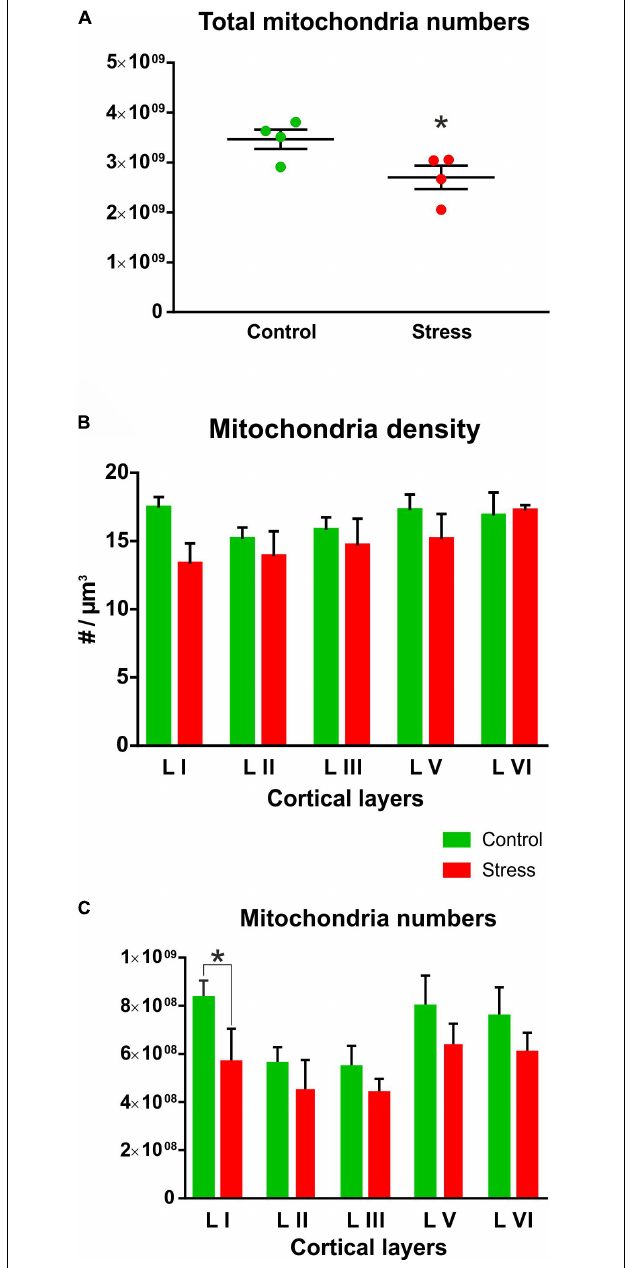
FIGURE 4 | (A) Chronic mild stress significantly reduced the total number of mitochondria in the infralimbic cortex ( t test, * P = 0.04). Total mitochondria numbers in the infralimbic cortex were calculated by multiplying mitochondria densities with the volume of the infralimbic cortex. (B) Mitochondria densities were only marginally reduced in the different cortical layers of the stressed animals, but these changes were not statistically significant (stress effect: P = 0.07). (C) Mitochondria numbers in the different cortical layers were compared with two-way ANOVA (stress × cortical layer) which revealed a significant difference between cortical layers ( P < 0.0001) and also a significant stress effect ( P < 0.0001). Sidak’s post hoc test found significant difference between control and stressed animals only in the first cortical layer (* P = 0.004). Mitochondria numbers within the cortical layers were calculated by multiplying mitochondria densities with the different cortical layer